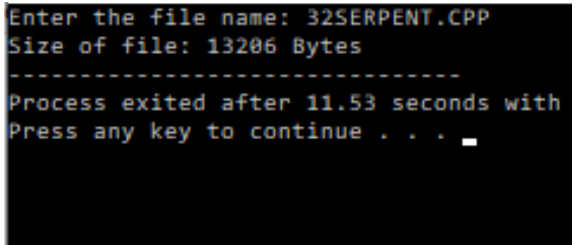
Figure 15. Experimental memory of Serpent for installation.